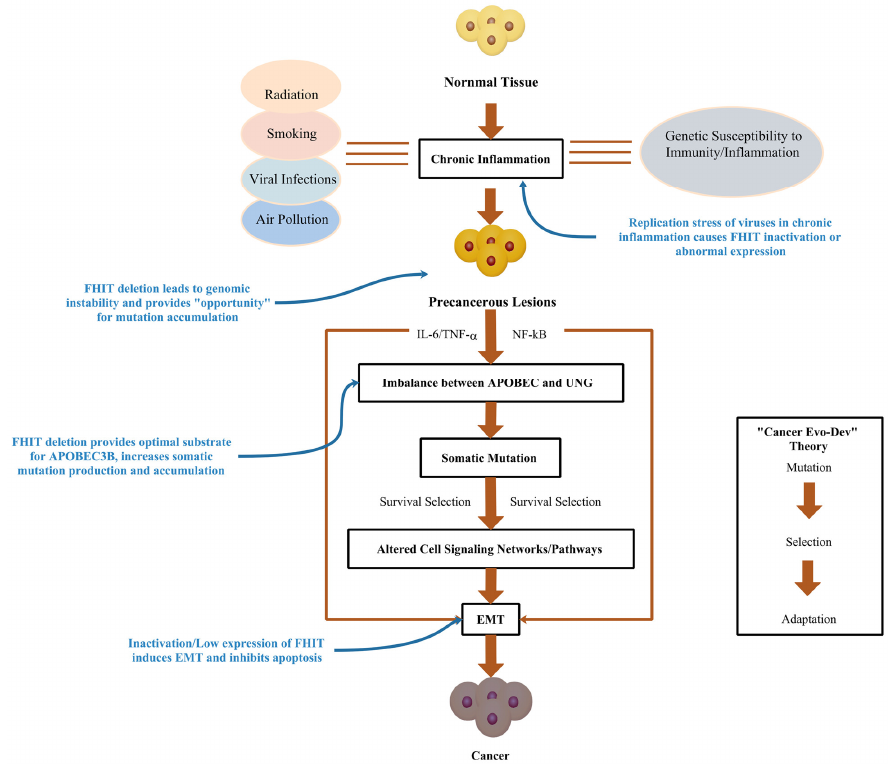
Figure 1. Potential Role of FHIT in Cancer Evo-Dev.